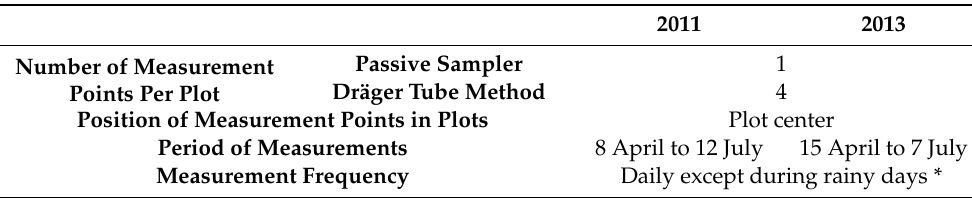
Table 4. Overview of NH 3 measurements in a 2-year study in 2011 and